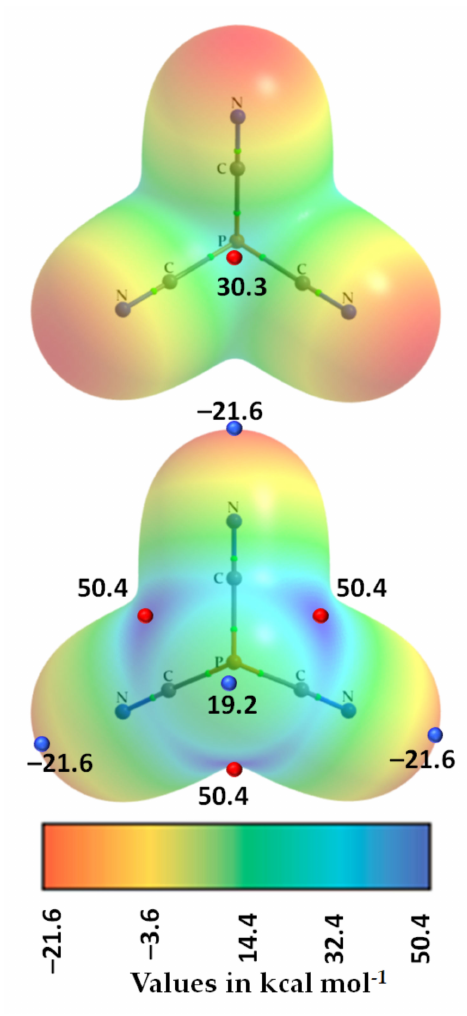
Figure 8. MP2(full)/def2-TZVPPD level molecular electrostatic surface potential plot of an isolated P(CN) 3 molecule. The geometry of the molecule was optimized at the same level of theory. The 0.001 a.u. isodensity envelope was used to compute the electrostatic potential. The tiny spheres in red and blue represent V S,max and V S,min , respectively. The QTAIM-based molecular graphs are superimposed on each case, and the bond paths are in atom color, accompanied by bond critical points (tiny sphere in green). The atom type is